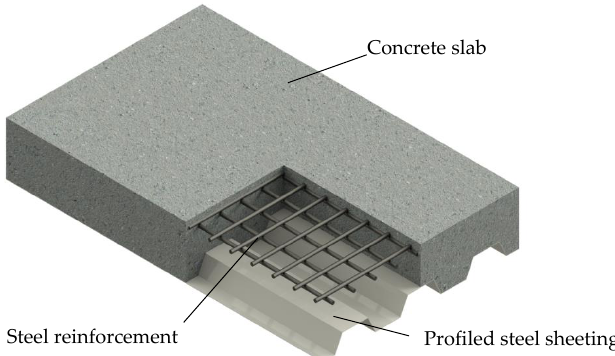
Figure 1 . Typical layout of the composite steel – concrete slab. Figure 1. Typical layout of the composite steel–concrete